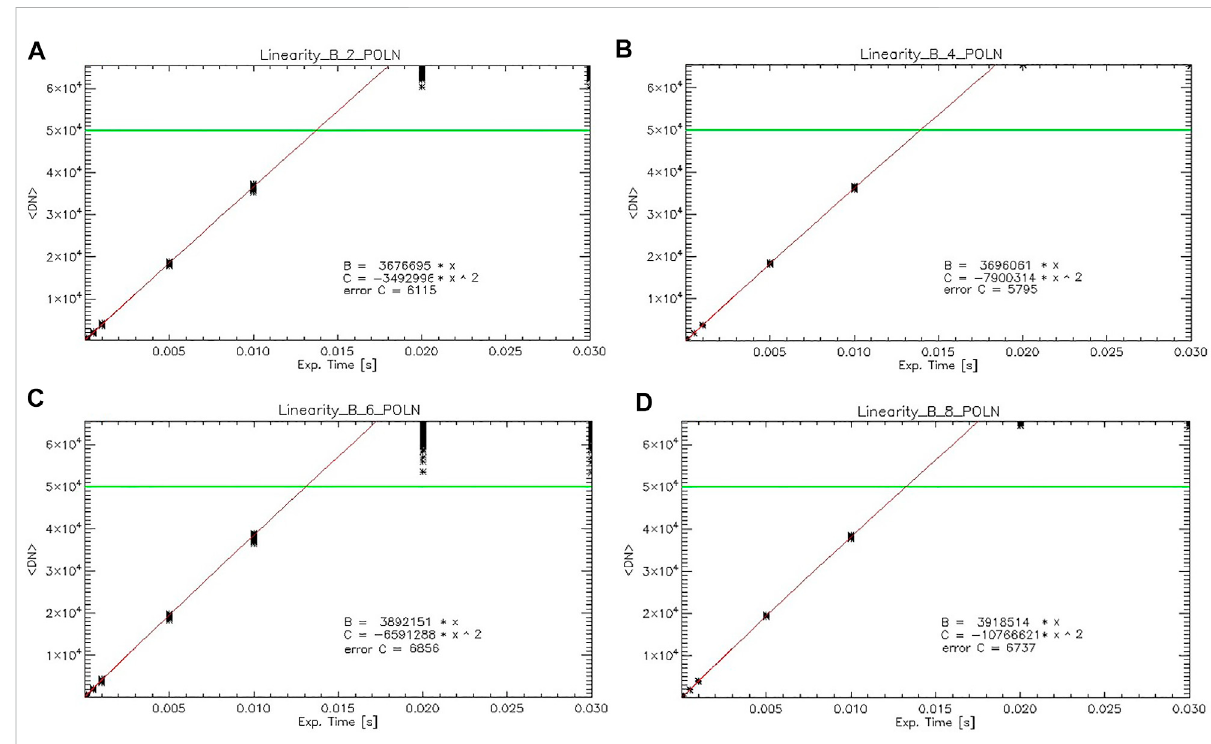
FIGURE 8 LinearityforPOLNblocks2 (A) and6 (C) arefromGlobalShutter,andblocks4 (B) and8 (D) arefromRollingShutter.B2andB4havethecooling ON, B6 and B8 do not. The red line represents the polynomial adjustment of least squares between the exposure time and the intensity. The green line de fi nes the intensity threshold. The coef fi cients present in the plot represent the coef fi cients of the line y = A + Bx + Cx 2